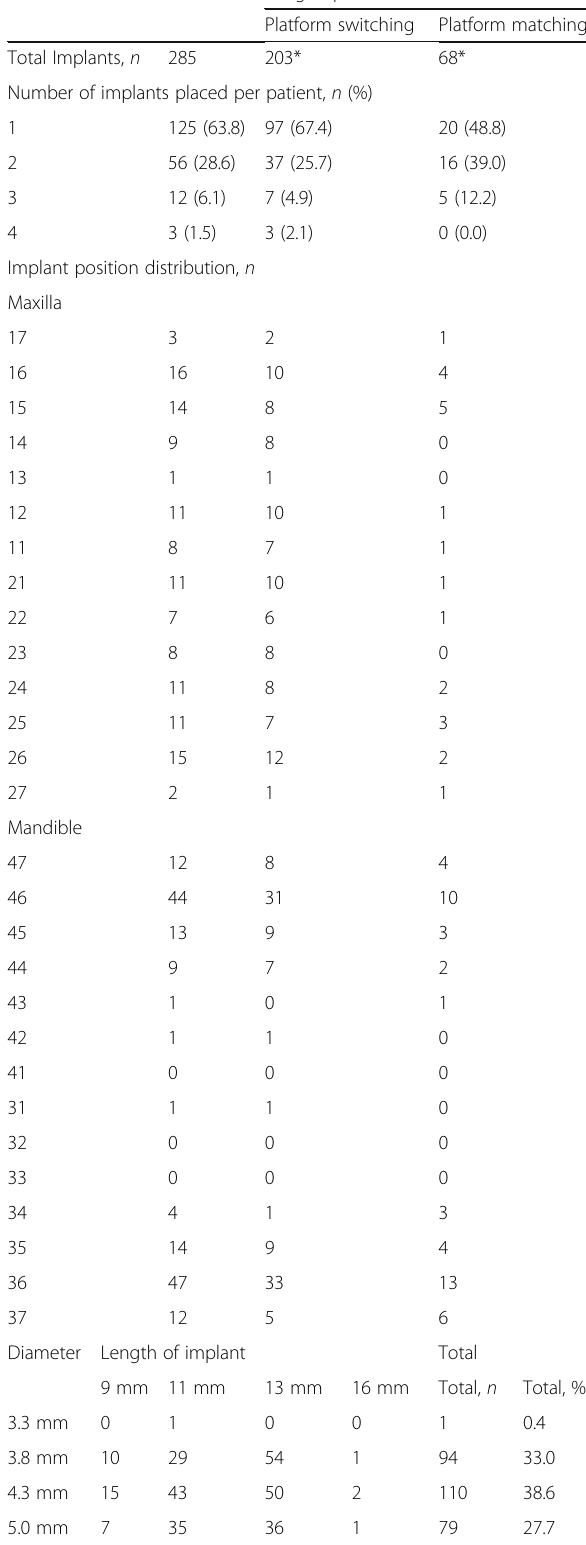
Table 3 Patient demographics with respect to implants